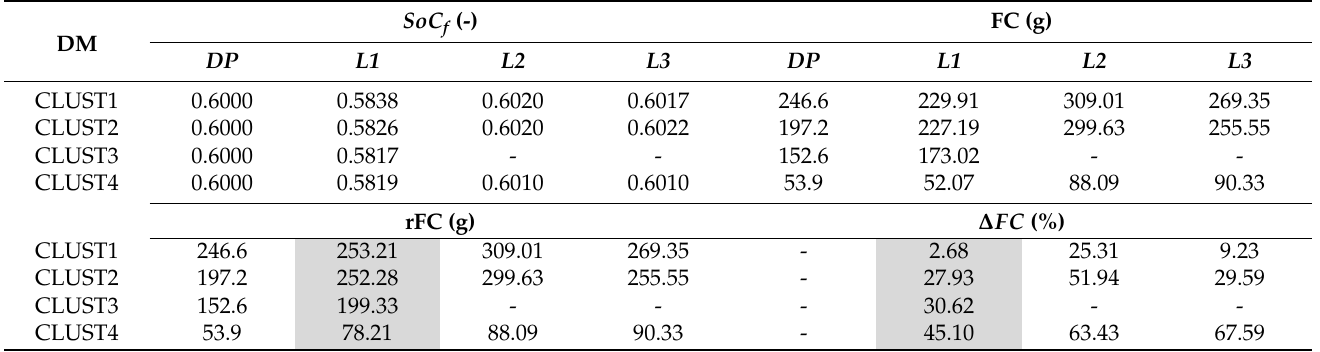
Table 7. Effects of a variation of the exploration strategy considering L1, L2 and